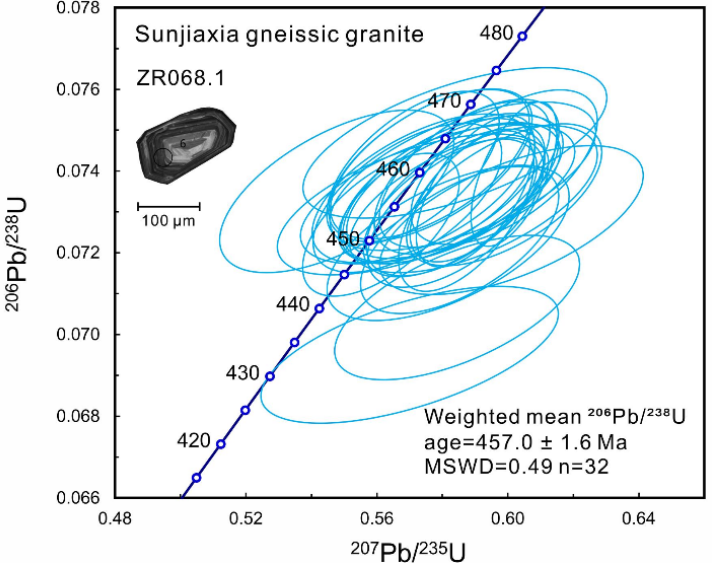
Figure 10. Primitive-mantle-normalized trace element diagram of the Liwanxincun metabasalt. PM data are from Sun and McDonough (1989) [26].